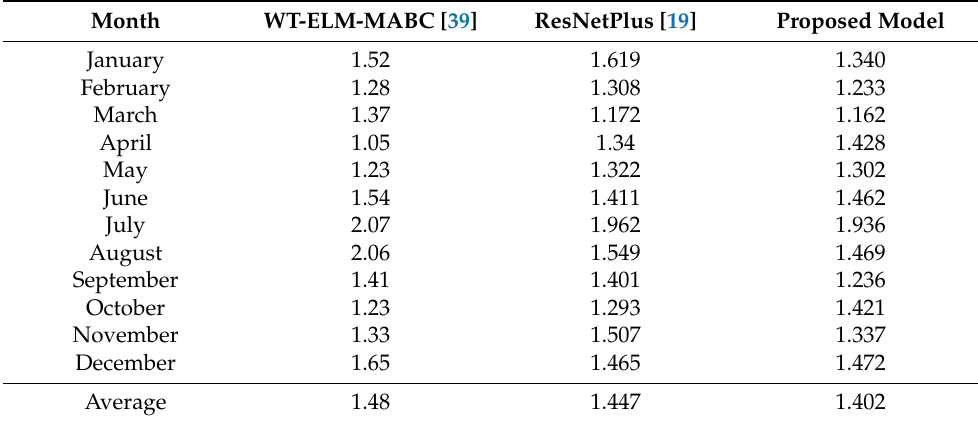
Table 5. Comparison to the existing methods—MAPE for load in ISO-NE of 2006 using actual